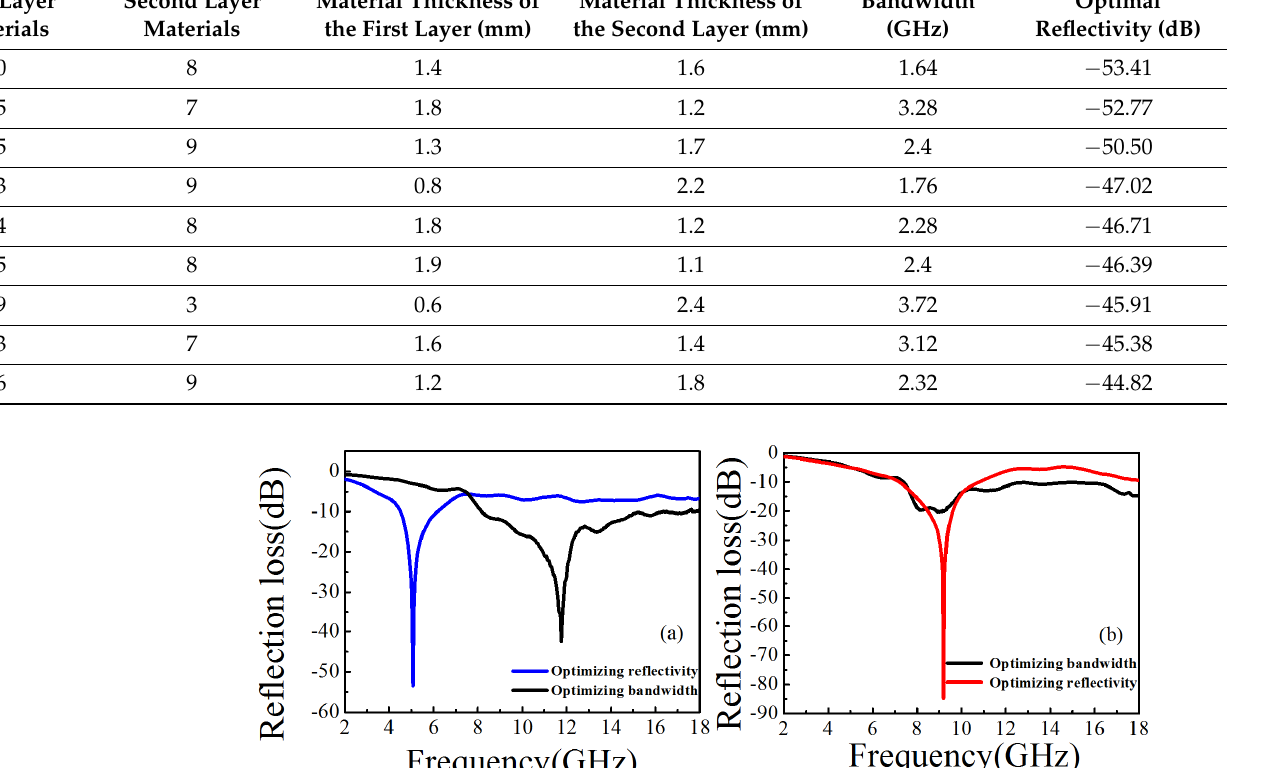
Table 9. The optimization results using objective function F2 (three-layers) of ABC algorithm. Table 7. The optimization results using objective function F2 (two-layers) of ABC algorithm. Frist Layer Frist Layer